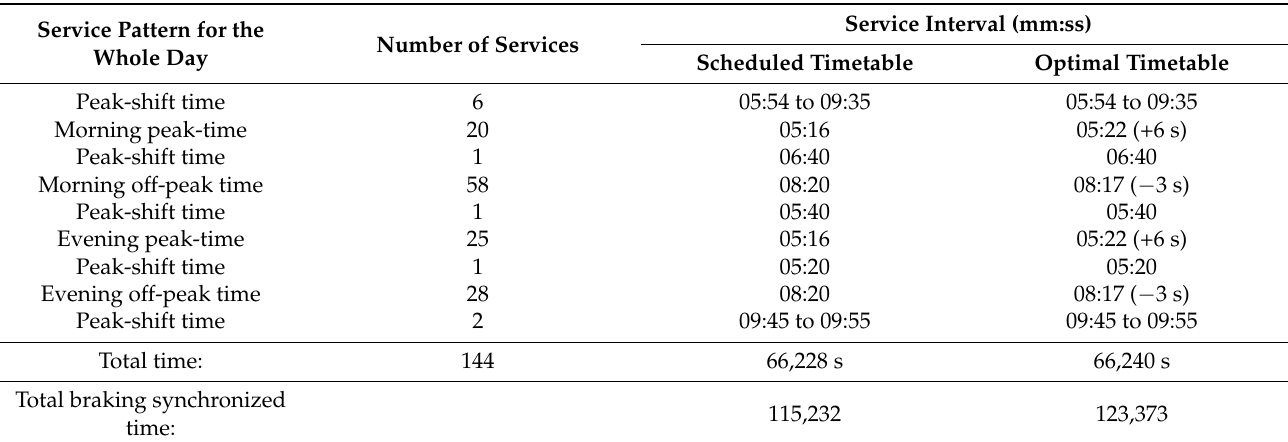
Table 3. Scheduled service intervals and optimal service